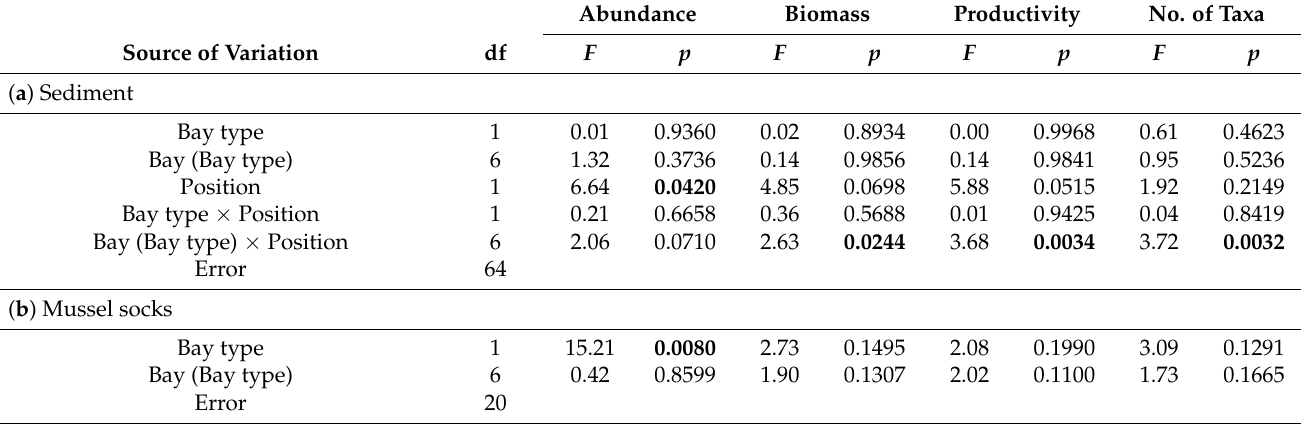
Table 3. Results of ANOVAs to evaluate fixed effects. ( a ) Bay type (with vs. without Styela clava ) and Position (inside vs. outside mussel leases) on log (x + 1)-transformed sediment macroinvertebrate abundance, biomass, productivity, and taxonomic richness, and ( b ) Bay type on log-transformed mussel sock macroinvertebrate abundance, biomass, and productivity. Statistically significant effects are indicated in bold. Abundance Biomass Productivity No. of Taxa Source of Variation df